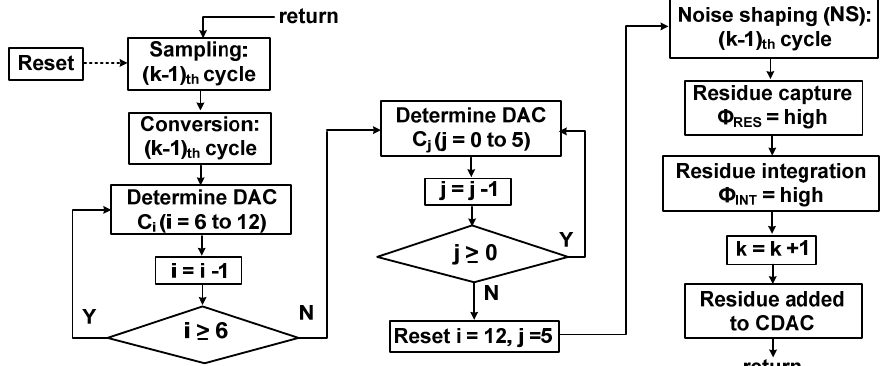
Figure 4. Flowchart of the proposed ADC operation during ( k − 1) th cycle.